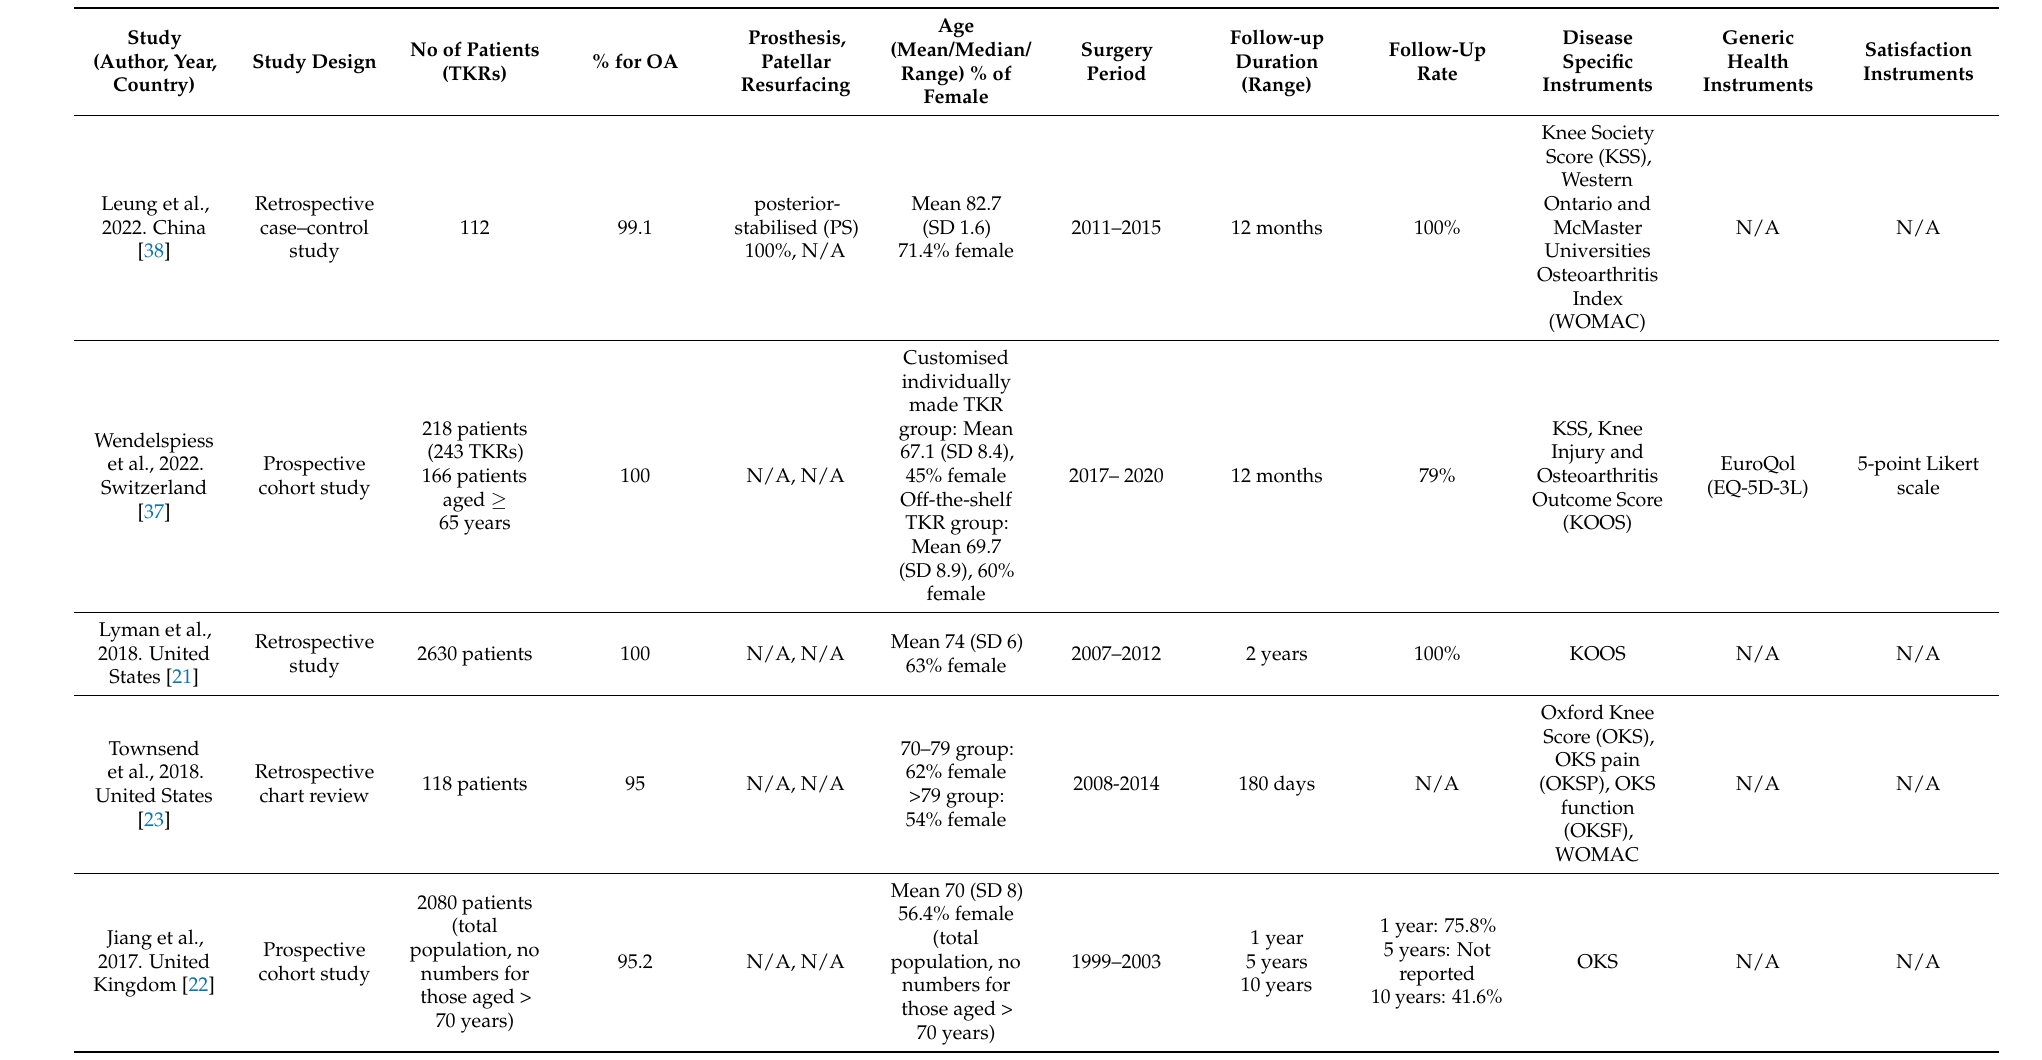
Table 1. Characteristics of included